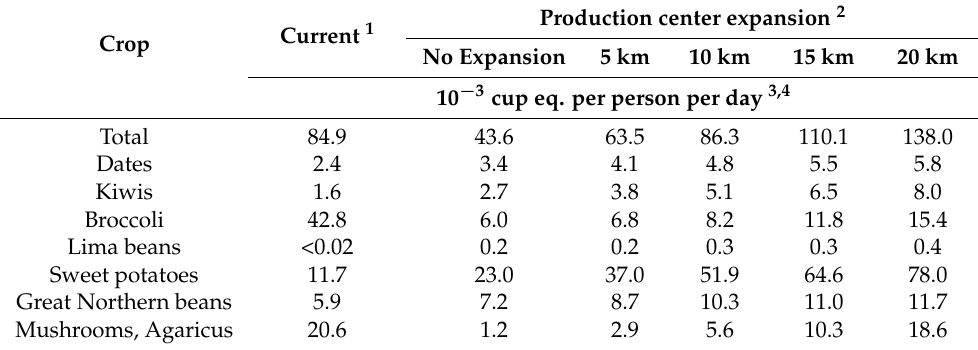
Table 3. Current and potential per capita availability of nutrient dense fruits and vegetables.